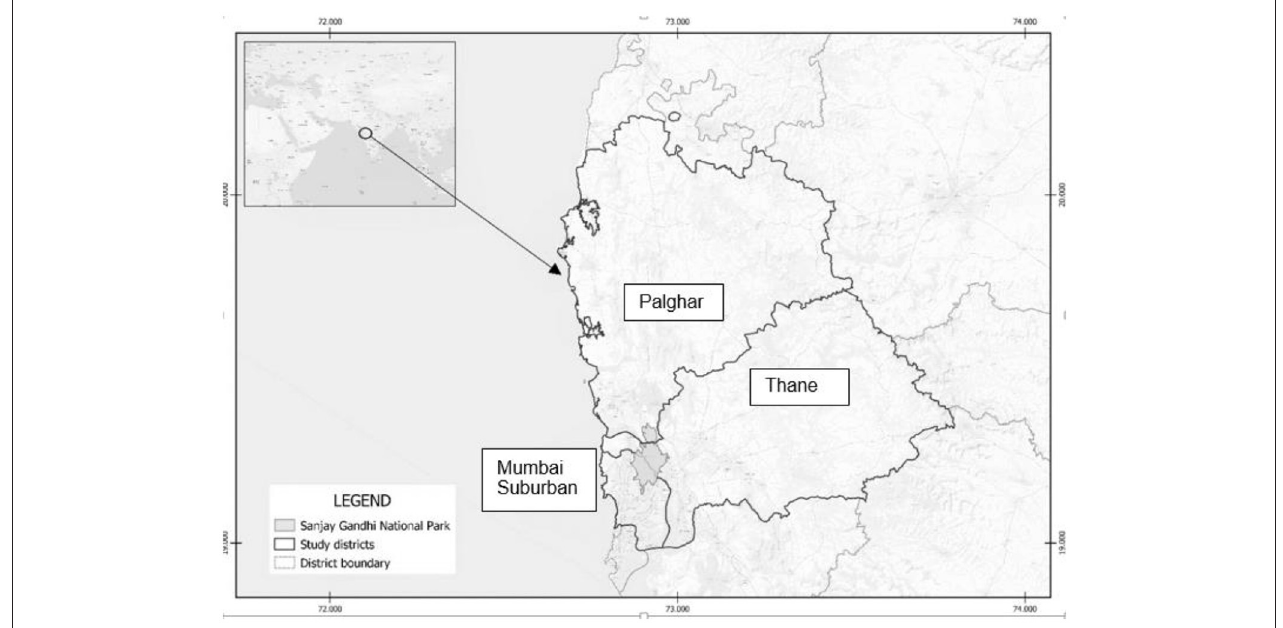
FIGURE 1 | The study was conducted in parts of the districts Palghar, Thane, and Mumbai Suburban in Maharashtra, India. Map credits: Shweta